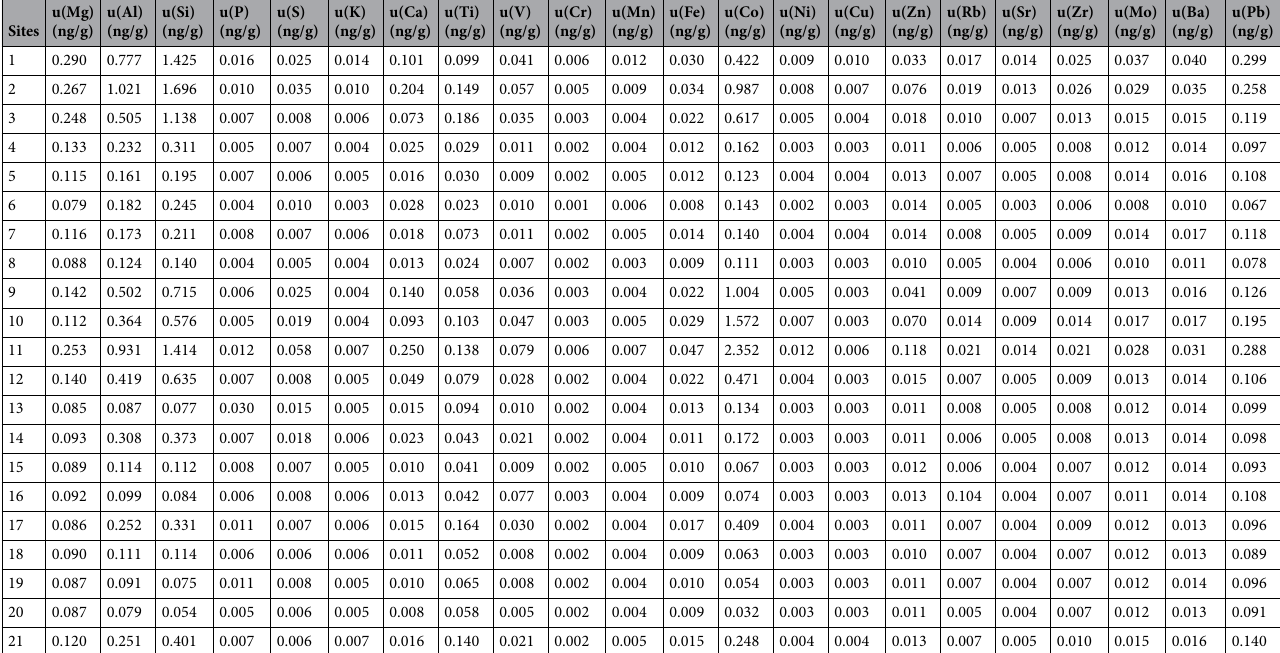
Table 3. Uncertainty associated with the element concentrations shown in Table